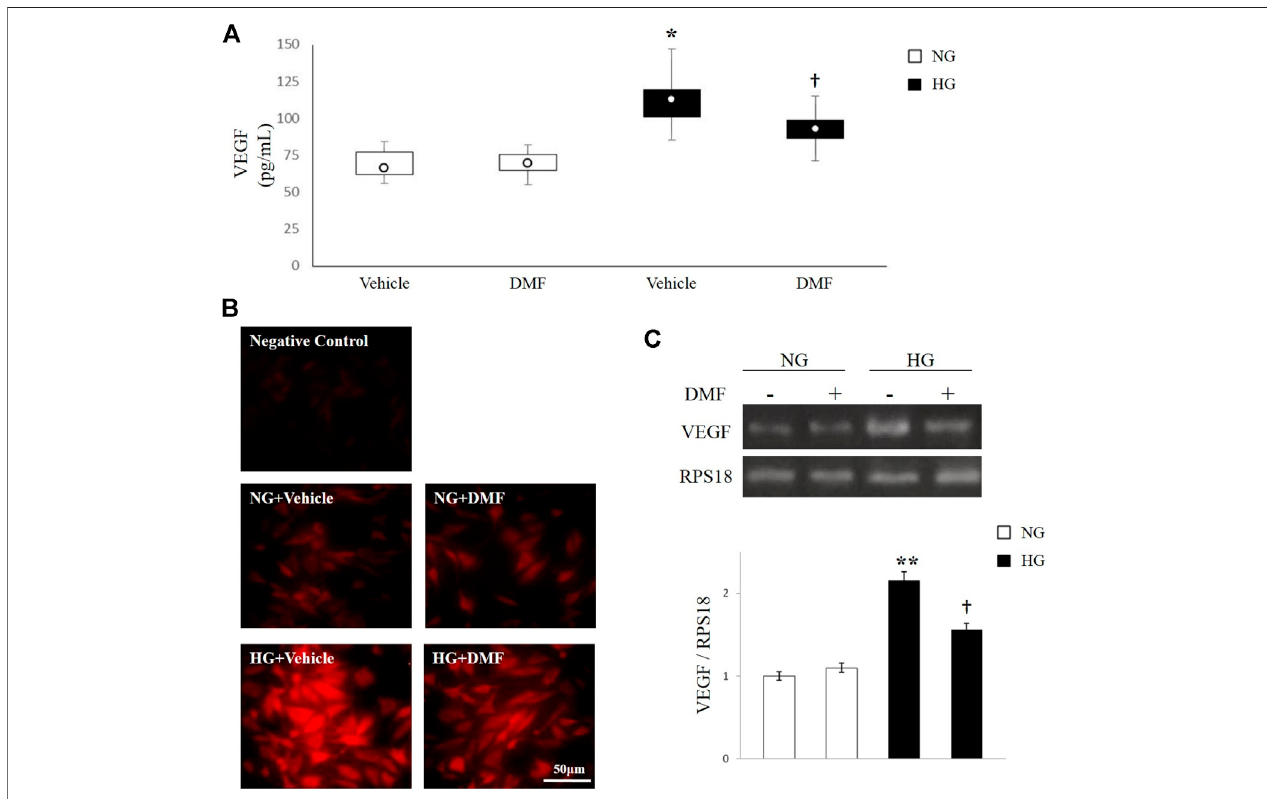
FIGURE 3 | Effects of DMF on VEGF levels. ARPE-19 cells exposed to normal glucose (NG) or high glucose (HG) w/or w/o DMF (10 μ M) for 24 h. (A) VEGF production was measured through ELISA. * p < 0.05 vs. Vehicle/NG; † p < 0.05 vs . Vehicle/HG; n (cid:2) 6. (B) Representative photomicrographs showing VEGF expression (red). Photomicrographs are representative results of fi elds taken randomly from each slide and observed by Axiovert 40 epi fl uorescence microscope (magni fi cation × 40). (C) Semi-quantitative RT-PCR shows VEGF mRNA expression normalized to the ribosomal protein S18 (RPS18, housekeeping gene). ** p < 0.01 vs. NG untreated cells, † p < 0.05 vs. untreated/HG; n (cid:2)